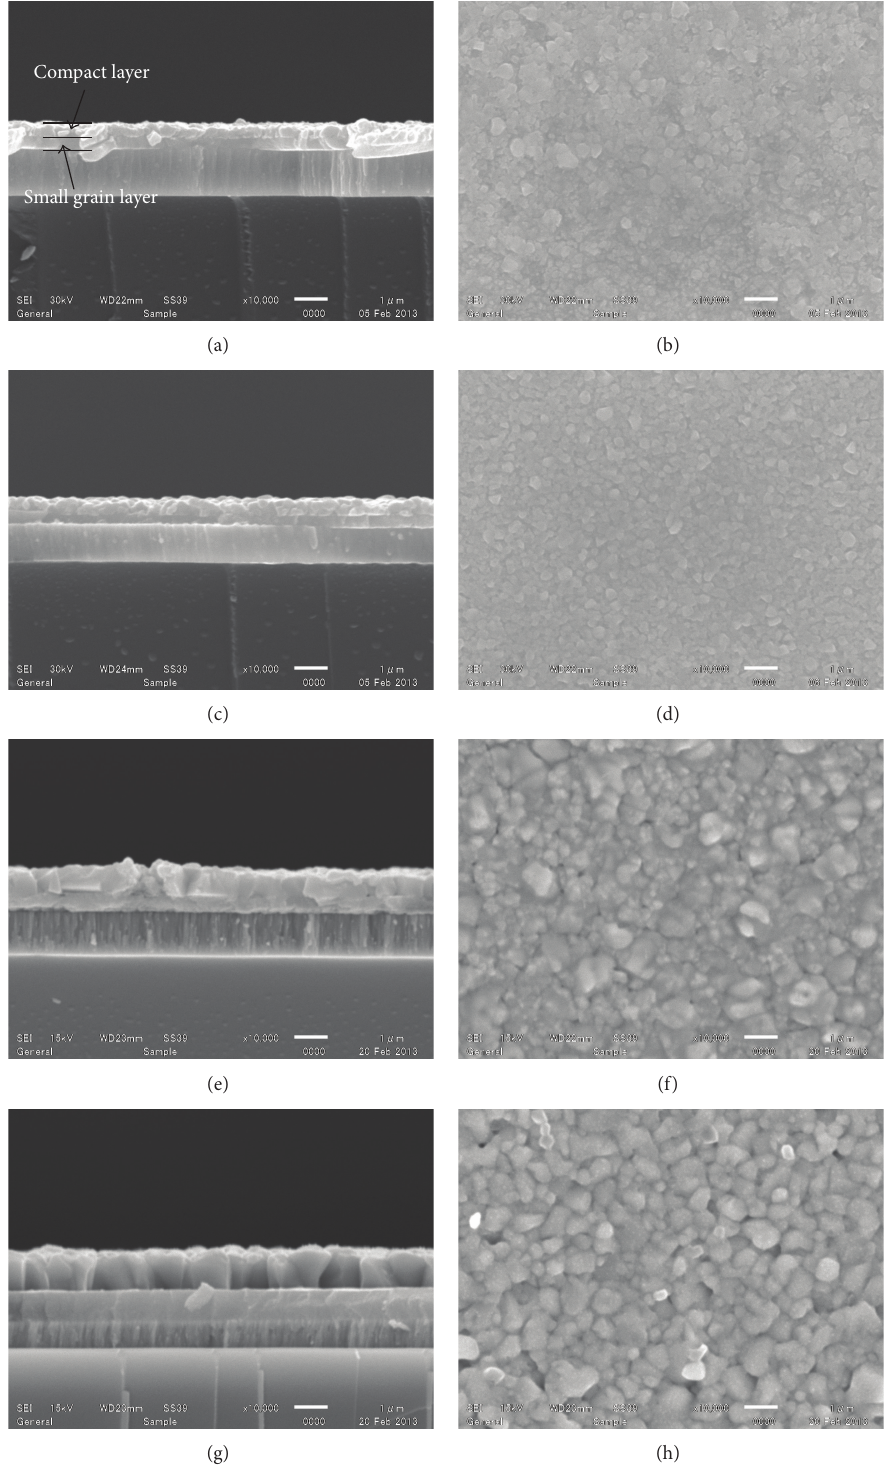
Figure 3: Cross-sectional and surface SEM images of CIGS films annealed at temperatures of 500 ((a), (b)), 520 ((c), (d)), 540 ((e), (f)), and 560 ∘ C ((g), (h)) for 30 min under a selenium vapor